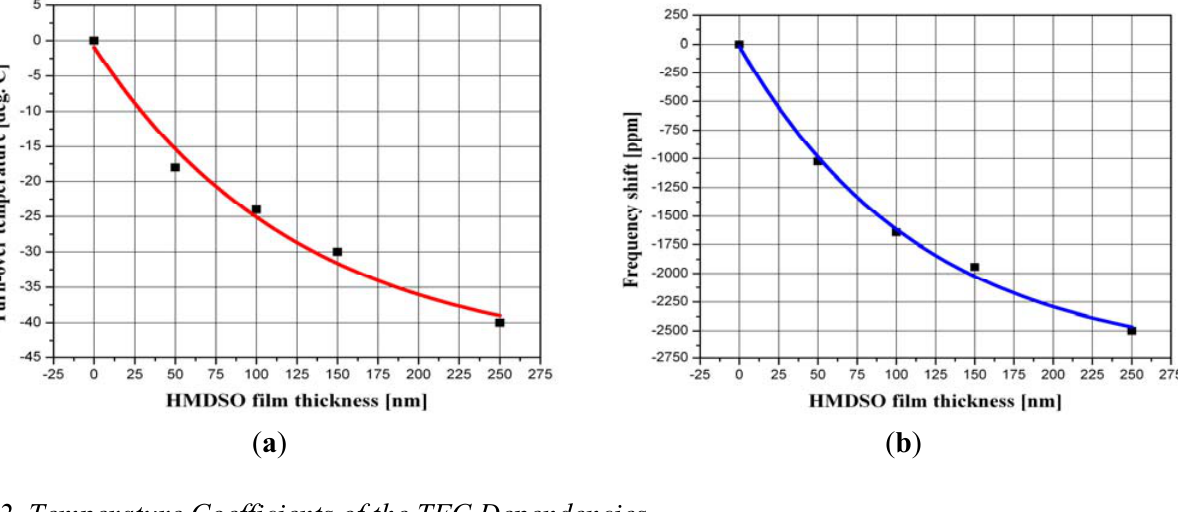
Figure 8. ( a ) Turn-over temperature and ( b ) resonance frequency shift versus HMDSO polymer thickness in RSAW based resonance sensors. The red and blue curves are exponential